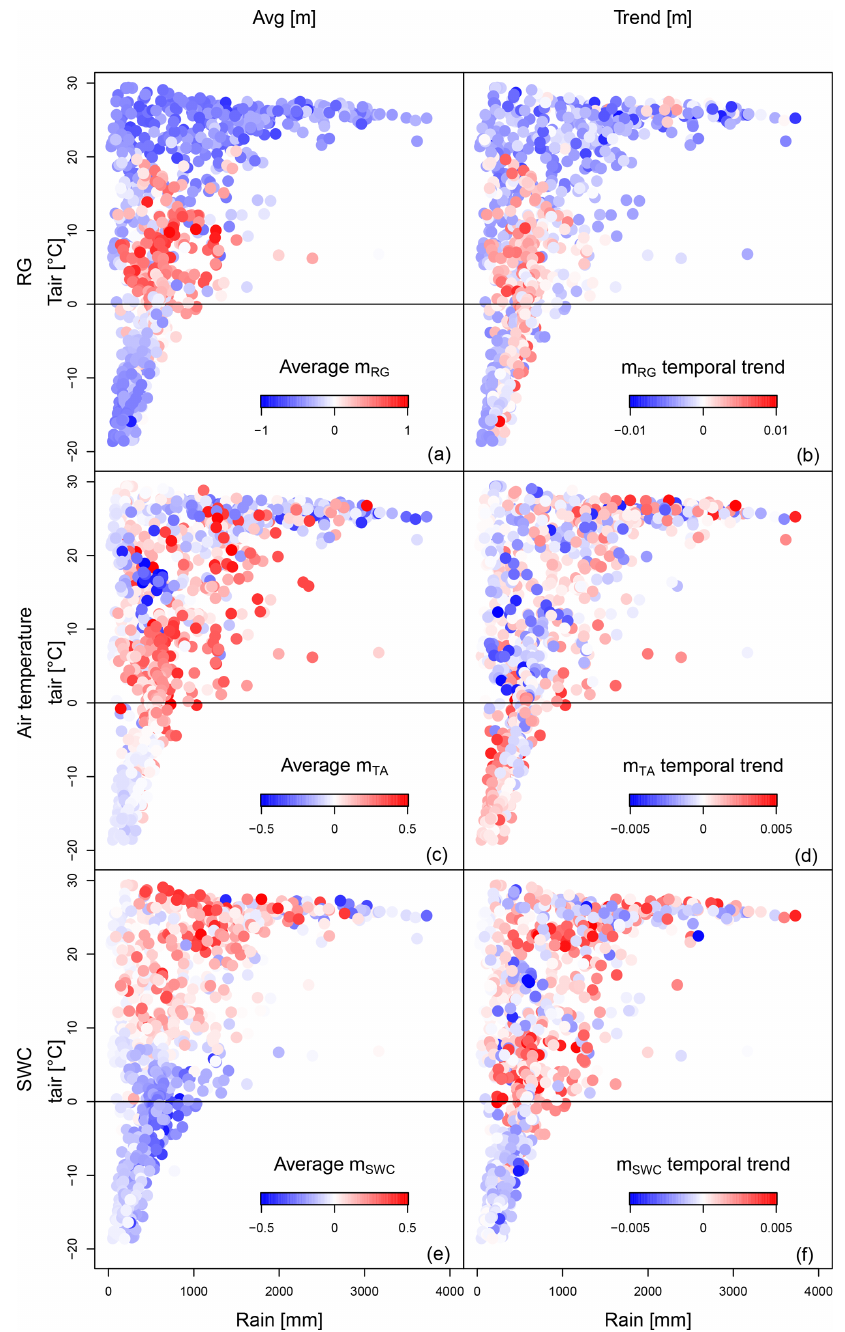
Figure 5. Scatter plots of sensitivity to climate drivers (a, c, e) and of trends of the sensitivities (b, d, f) plotted in a precipitation–temperature space at a weekly